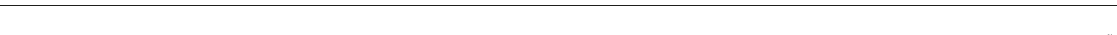
Fig. 8 NGS analysis of intestinal organoids after deletion of Ap4 . a GSEA comparing gene expression pro fi les from Vil-Cre-ERT2 and Vil-Cre-ERT2/Ap4 fl / fl organoids 7 days after Cre activation by 4-OHT with Lgr5-positive stem cell signatures 13 , β -catenin regulated/ISC-speci fi c genes 60 , Notch targets genes 61 or c-Myc target genes (mSigDB: molecular Signatures Database). NES: normalized enrichment score, Nom. p-value: nominal p-value. b Heatmap depicting expression changes of selected differentially expressed mRNAs ( p -value < 0.05) from stem cell gene signatures, Wnt signaling and/or Notch signaling gene signatures analyzed in a . The heatmap displays relative expression levels normalized to the mean expression in the control ( Vil-CreERT2 ) samples for each mRNA. Three biological replicates per genotype were analyzed. c qPCR analysis of the indicated mRNA of organoids with the indicated genotypes 3 days and 7 days after 4-OHT induction. d Scatter plot displaying the correlation of expression changes of the 424 mRNAs signi fi cantly ( p < 0.05) downregulated in both adenomas and organoids (shown in gray).The mRNAs from stem cell gene signatures, Notch target gene signatures and c-Myc target genes analyzed in Figs. 4a and 8a in both adenomas and organoids are highlighted with the indicated colors. The Pearson correlation coef fi cient of